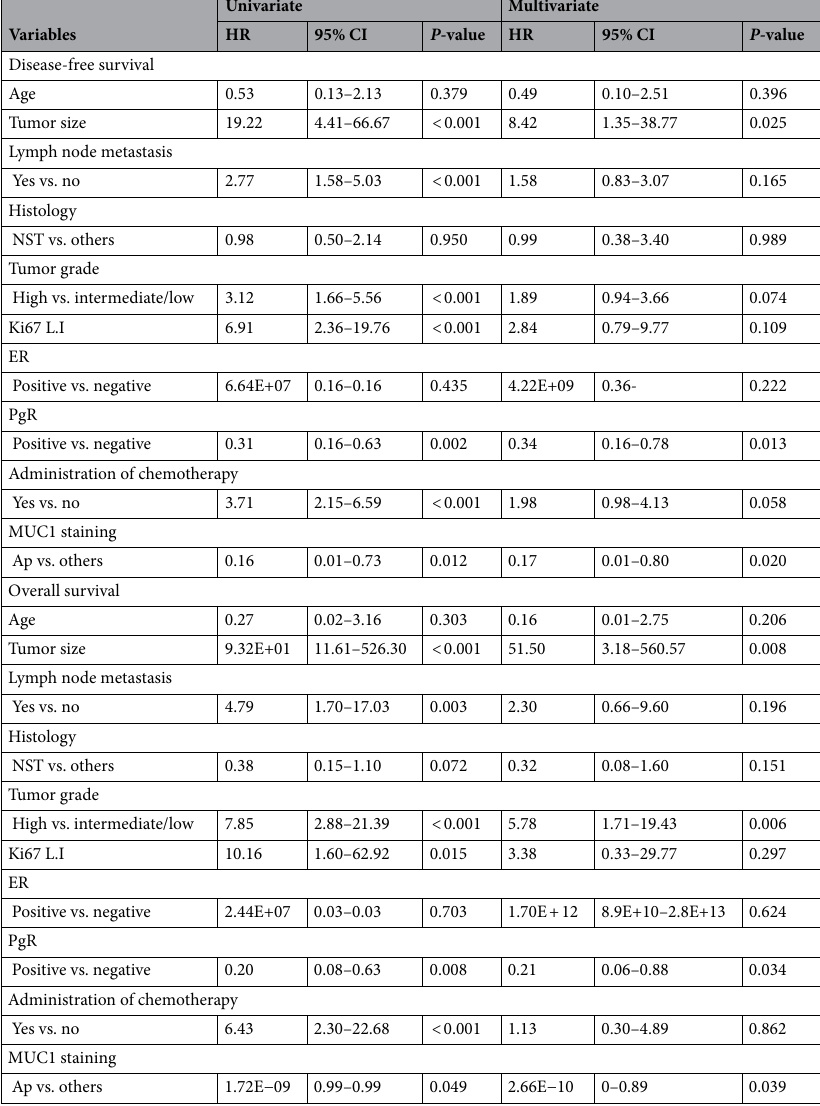
Table 2. Relationship between patient outcomes and clinicopathological features in the tissue microarray- cohort. HR hazard ratio, CI confidence interval, NST no special type, L.I. labelling index, ER estrogen receptor, PgR progesterone receptor, Ap